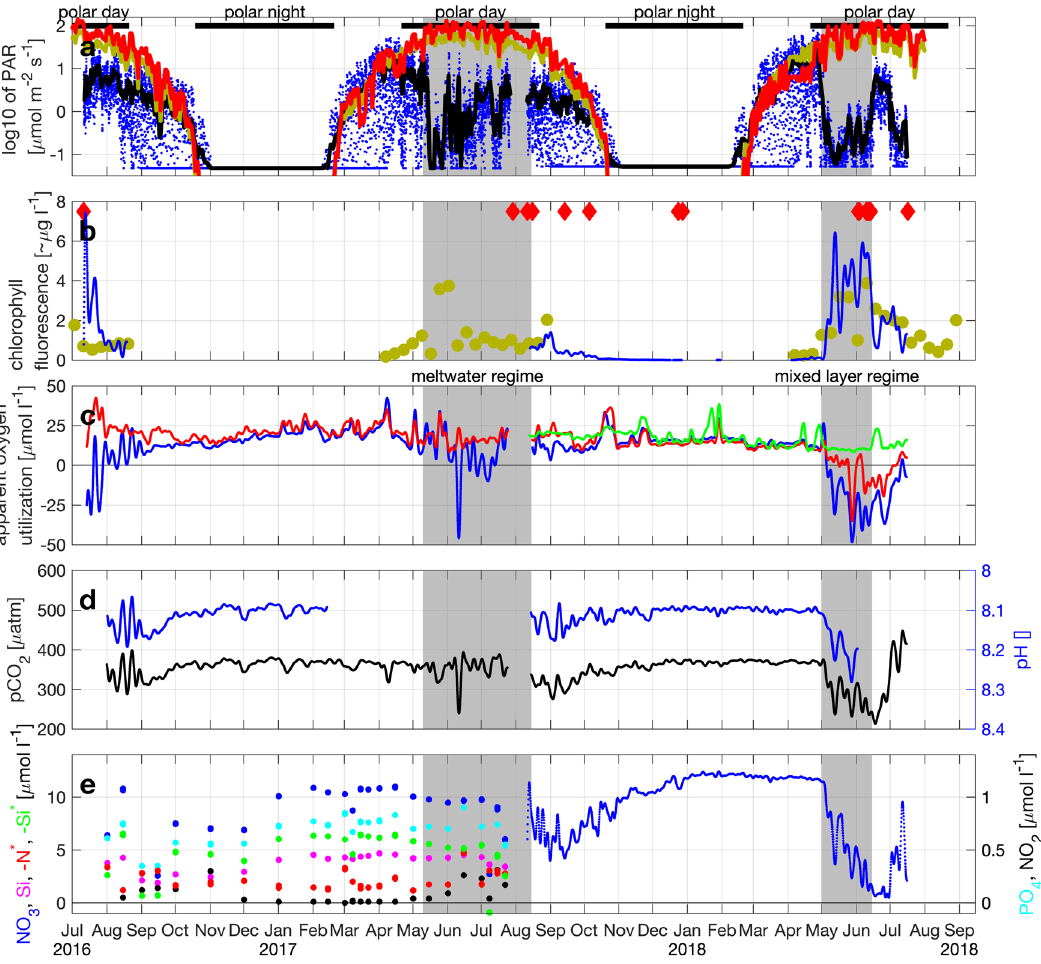
Fig. 5 Upper ocean biogeochemistry at HG-IV from upper instrument depth (~30 m). a Logarithm of photosynthetically available radiation [ μ molm − 2 s − 1 ] from hourly sensor measurements at depth (blue) and their 5-day average (black); from reanalysis at the surface reduced to 30m depth using a constant extinction coef fi cient in order to make it comparable to the sensor measurements (dark yellow); and from the reanalysis value distributed over the mixed layer depth (red). b Chlorophyll a concentration [~ μ g l − 1 ] from chlorophyll fl uorescence sensor measurements (blue); and from average of Sentinel 3A OLCI satellite grid points within 30-km radius of mooring location (dark yellow); times when individual 1-second measurements of scattering exceeded 0.002m − 1 sr − 1 (red diamonds) indicative of aggregation. c Apparent oxygen utilization [ μ mol l − 1 ] at the three measurement depths as colored in Fig. 4c. d pCO 2 [ μ atm] (black) and pH [] (blue); note the reversed y -axis for pH. e Inorganic nutrients [ μ mol l − 1 ] from water samples in 2016 – 2017 and from nitrate sensor in 2017 – 2018; nitrate (blue), silicate (magenta), phosphate (cyan), nitrite (black); negative of (N* = nitrate-phosphate*16) (red); negative of (Si* = silicate-nitrate) (green); note the different y -scale for phosphate and